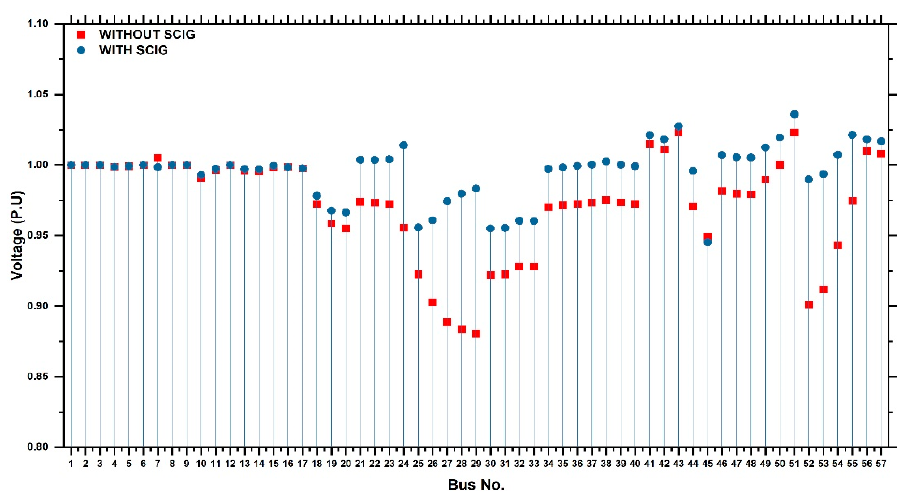
Figure 10. Load 2—voltage profile with and without a SCIG.